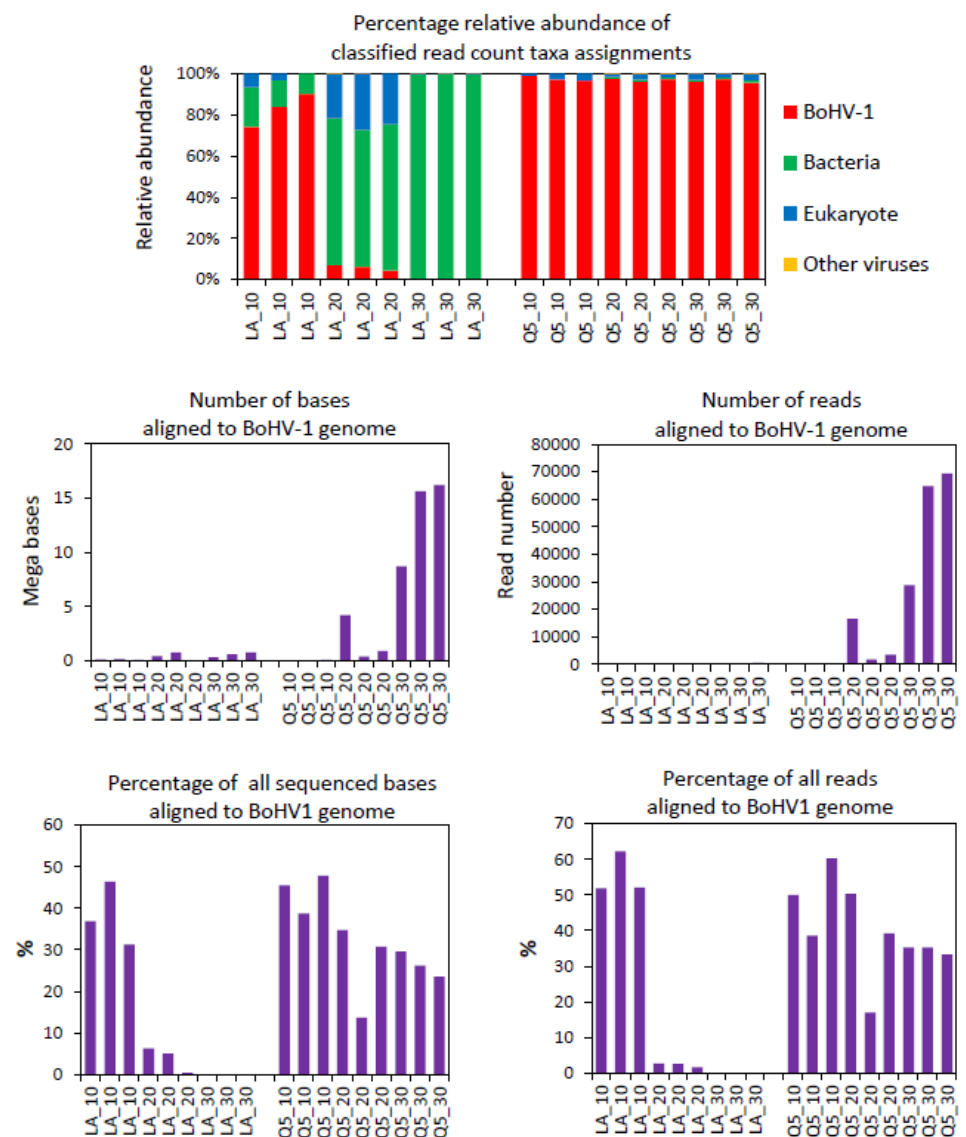
Figure 2. Comparison of BoHV-1 sequences generated from MinION sequencing libraries that were PCR amplified for 10, 20 or 30 cycles with either NEB Next Ultra II Q5 Master Mix (Q5) or NEB LongAmp Taq 2 × Master Mix (LA) polymerases. Percentage read counts for taxonomic assignments were generated using Epi2ME Fastq WIMP Workflow analysis of FASTQ files. The number and percentage of aligned bases and reads were generated via alignment (using Epi2ME Fastq Custom Alignment) to the bovine herpesvirus type 1.1 complete reference genome (Genbank accession number AJ004801.1). Libraries were generated from the same nucleic extract (bead beating + nuclease) from BoHV-1 infected bFLCs using the ONT rapid PCR barcoding kit. Three libraries were generated for each of the 3 PCR cycle numbers. The graphs were created in Microsoft Excel and Microsoft PowerPoint in Microsoft Office Professional Plus